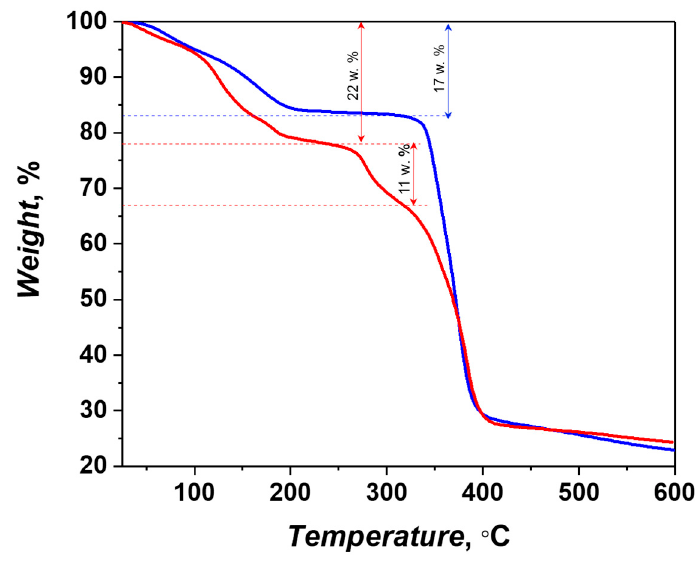
Figure 5. Thermogravimetric curves for compounds 1 (blue) and 2